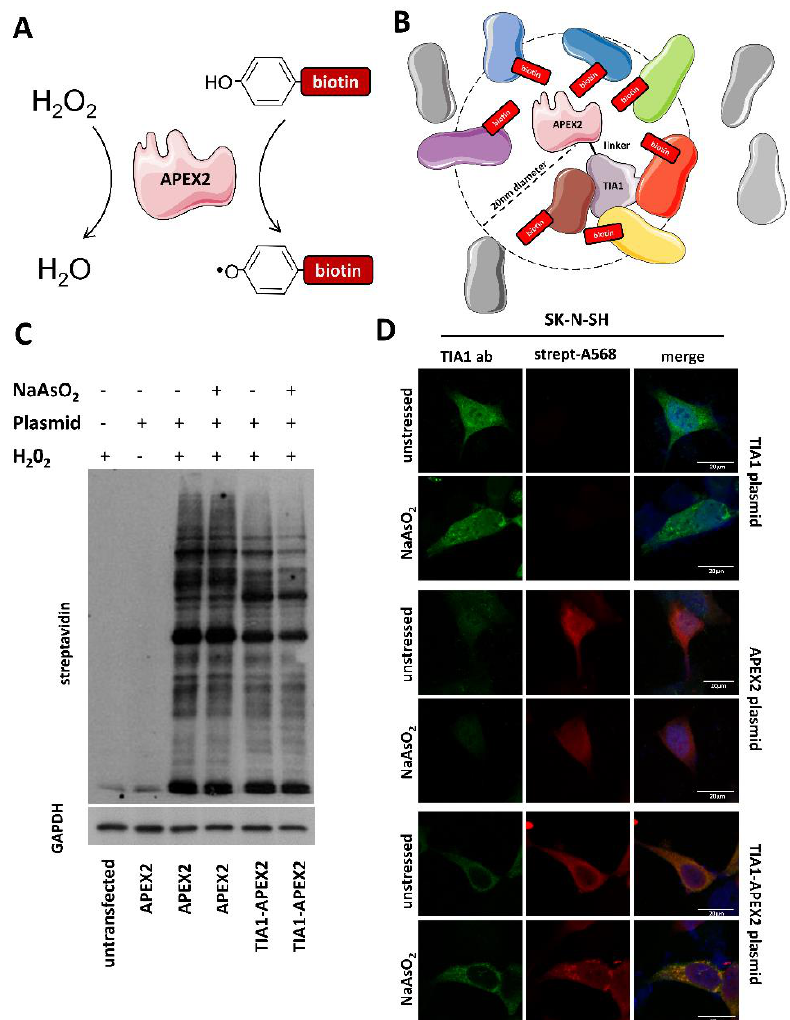
Figure 1. Proximity mapping of TIA1 interacting proteins by APEX2 mediated biotinylation. ( A ) H 2 O 2 activates the APEX2 enzyme, which catalyzes biotin-phenol oxidation to generate a short-lived biotin phenoxyl radical that covalently tags endogenous proteins proximal to APEX2. ( B ) Schematic diagram of the TIA1-APEX2 proximity labeling depicting a genetically engineered APEX enzyme tagged via a linker sequence to the C-terminus of the wild-type human TIA1. Labeled proteins are within 20 nm from the APEX2; some will directly interact with TIA1. ( C ) Neutravidin-HRP Western blotting of induced protein biotinylation in lysates from APEX2 or TIA1-APEX2 expressing cells. ( D ) Immunostaining of unstressed and sodium arsenite-treated SK-N-SH cells transfected with either TIA1, APEX2, or TIA1-APEX2 plasmids. Subcellular localization is altered upon stress for TIA1 and TIA1-APEX2, but not APEX2. Please refer to the supplementary material for uncropped Western Blot